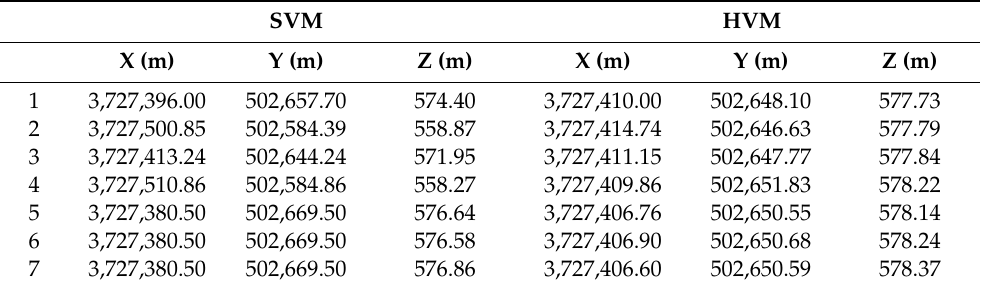
Figure 12. Spatial distribution of the microseismic event location (MEL) results based on the HVM and SVM. Table 6. Location results of the SVM and HVM for the seven blasting